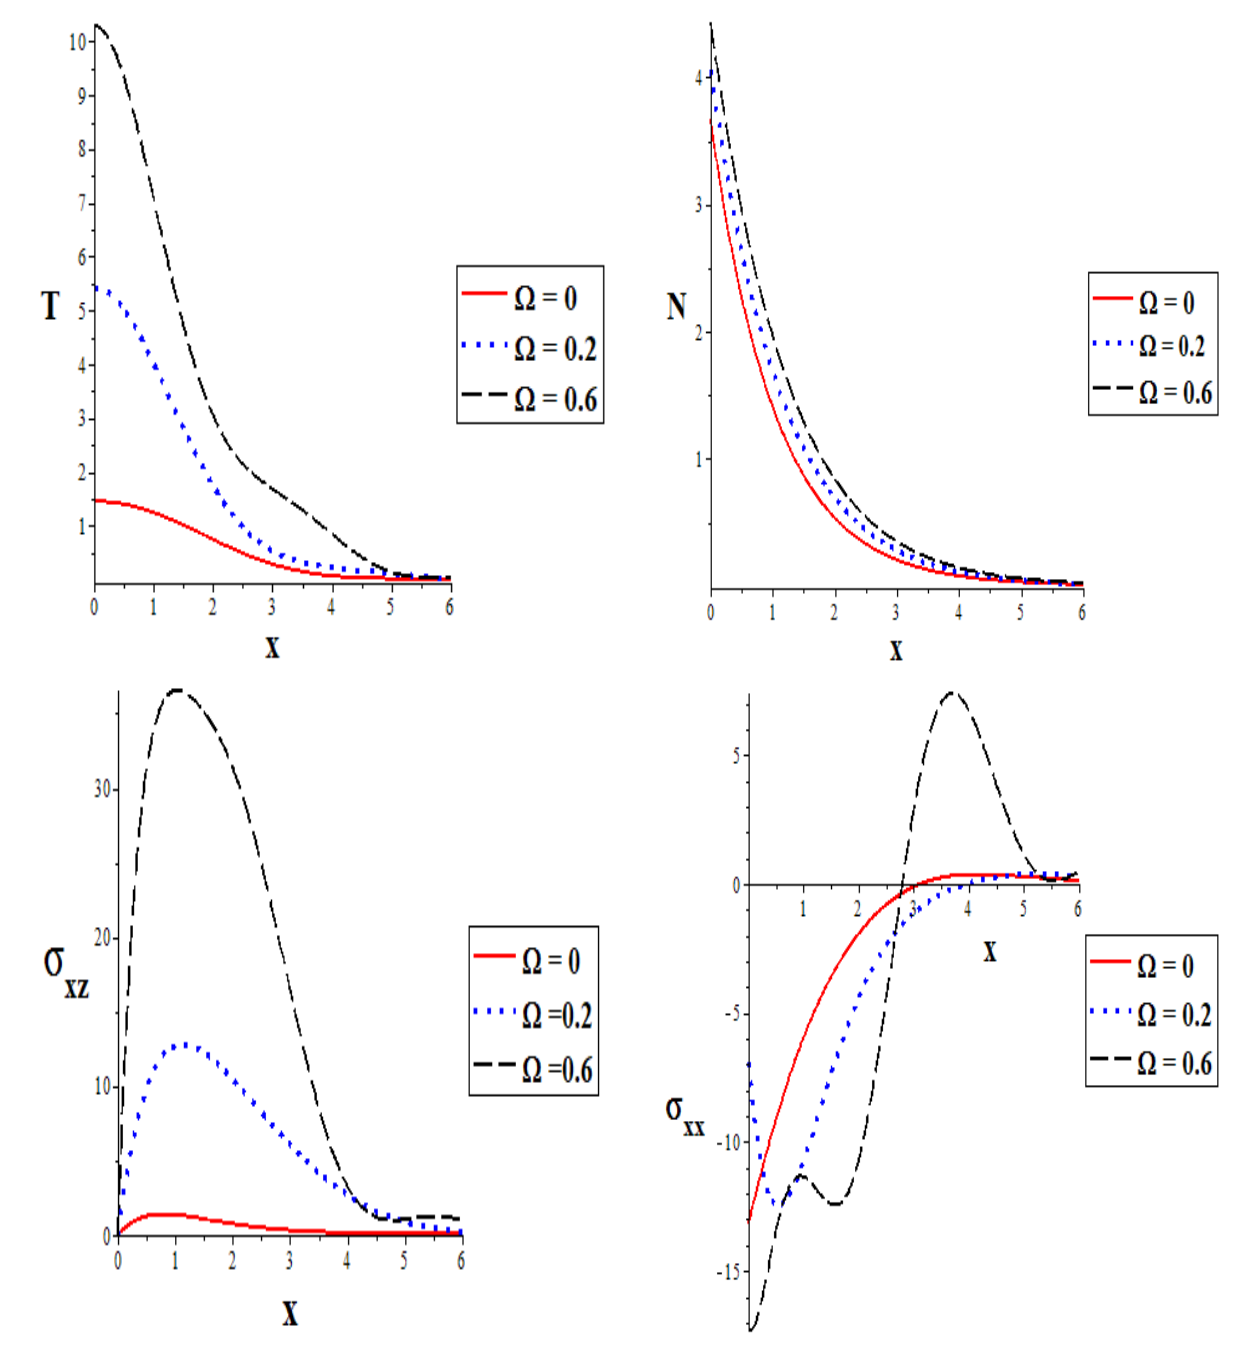
Figure 3. The main changes in the physical fields plotted against the horizontal distance for various small values of rotation parameters according to the MGT model in the presence of initial hydrostatic stress.